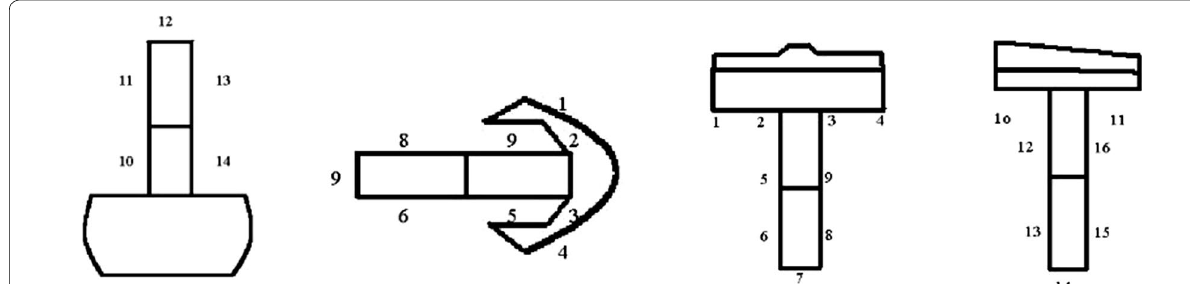
Fig. 1 Areas in the Fehring modified AKSS X‑ray evaluation